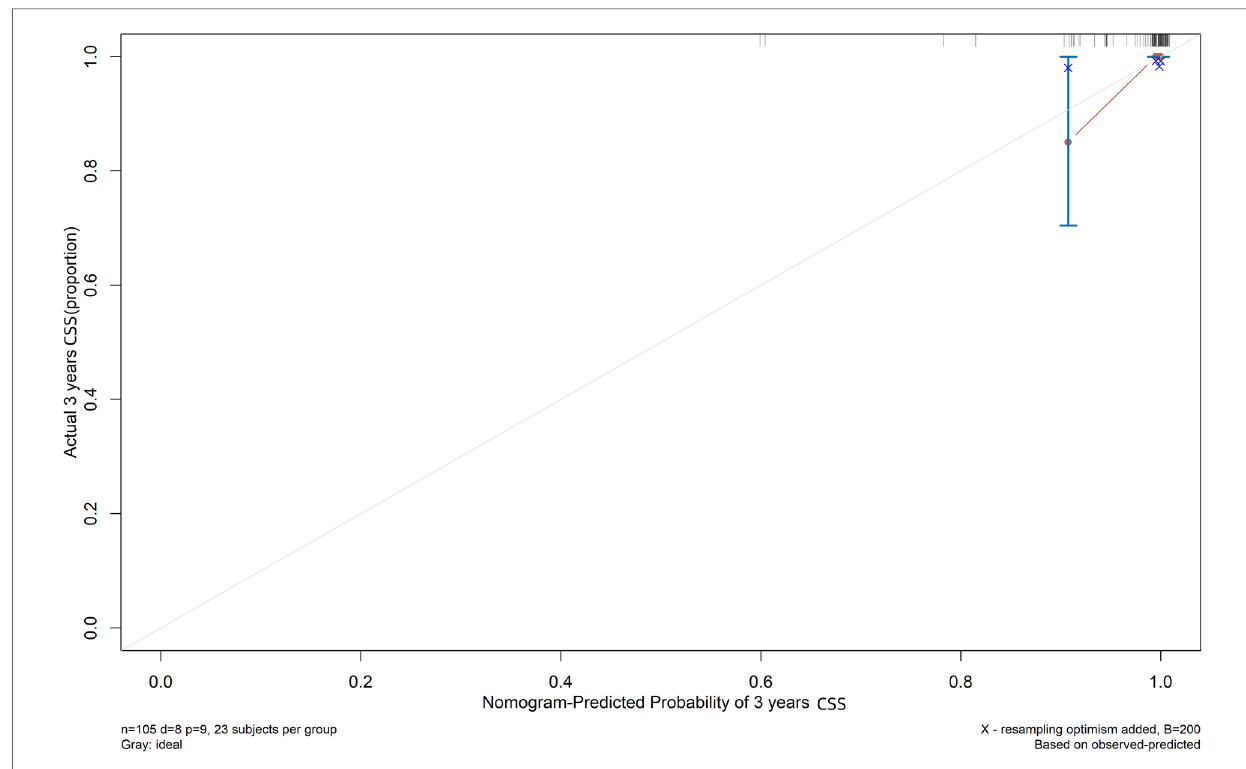
FIGURE 6 Calibration plot for cause-speci fi c mortality nomogram in TETs. The x-axis and y-axis respectively correspond to the predicted odds of cause-speci fi c survival and the actual observed incidence of cause-speci fi c survival (3-year) of validation